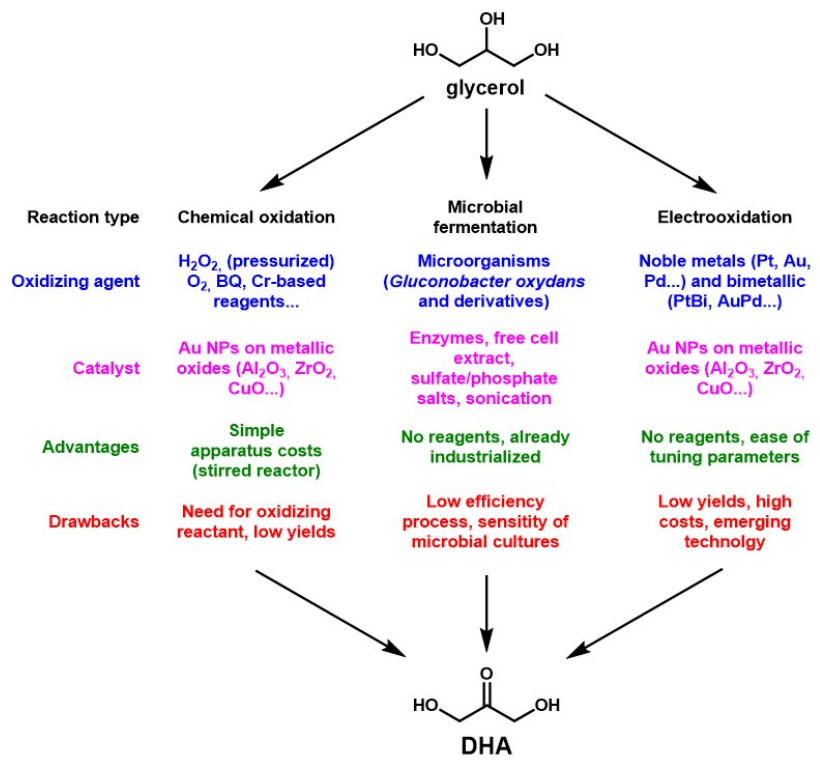
Figure 5. Schematic resume of the reported synthesis routes to produce DHA from